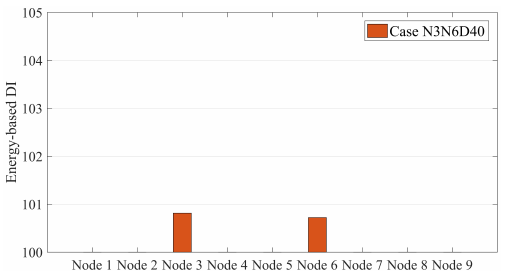
Figure 10. Energy-based DIs along a simply supported beam subjected to moving sprung mass with a speed of 2.5 m/s for multi-damage case